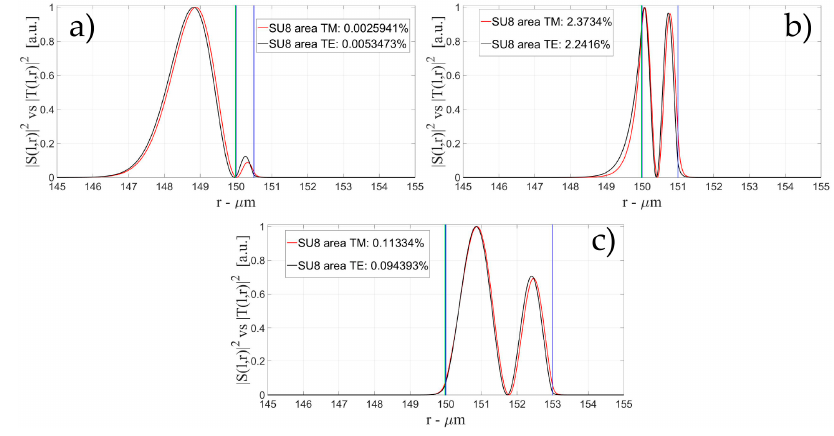
Figure 5. Electric field distribution of WGMs along the radial direction for TE (| S ( l,r ) | 2 ) and TM (| T ( l,r ) | 2 ) modes for the 2nd radial order and wall thickness: ( a ) for a wall of about 500 nm (minimum sensitivity); ( b ) for a wall of about 1 μ m (maximum sensitivity); and ( c ) for a wall of about 3 μ m (minimum sensitivity). Legends show the fraction of | S ( l,r ) | 2 and | T ( l,r ) | 2 inside the biological layer.